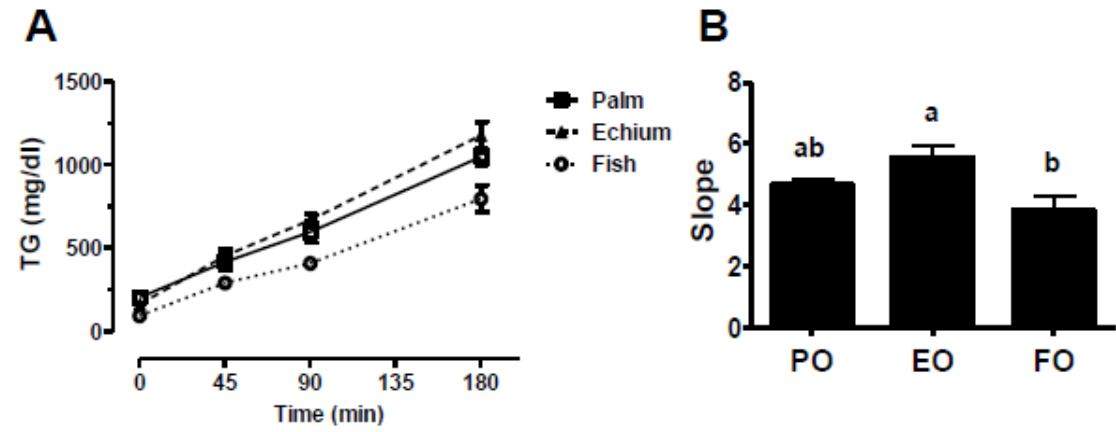
Figure 5. Hepatic TG secretion rate. ( A ) Mice fed PO, EO, or FO diets were fasted for 4 h before baseline TG values were determined by enzymatic analysis. Animals were injected retro-orbitally with Triton X-100 (500 mg/kg mouse) to block lipase activity. Hepatic TG secretion rate was calculated by measuring TG accumulation in plasma 45, 90, and 180 min post-injection. ( B ) Slopes of hepatic TG secretion shown in Panel A . Values represent mean ± S.E.M. Values with different letters are significantly different ( p <